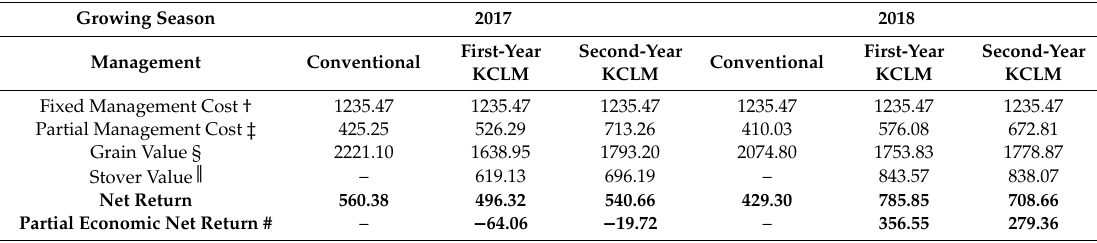
Table 2. Growing season and treatment means, standard error, and statistical significance of dependent variables for first-year maize. Table 6. Economic return (in U.S. $ ha − 1 ) for maize produced conventionally and in KCLM in 2017 and 2018.